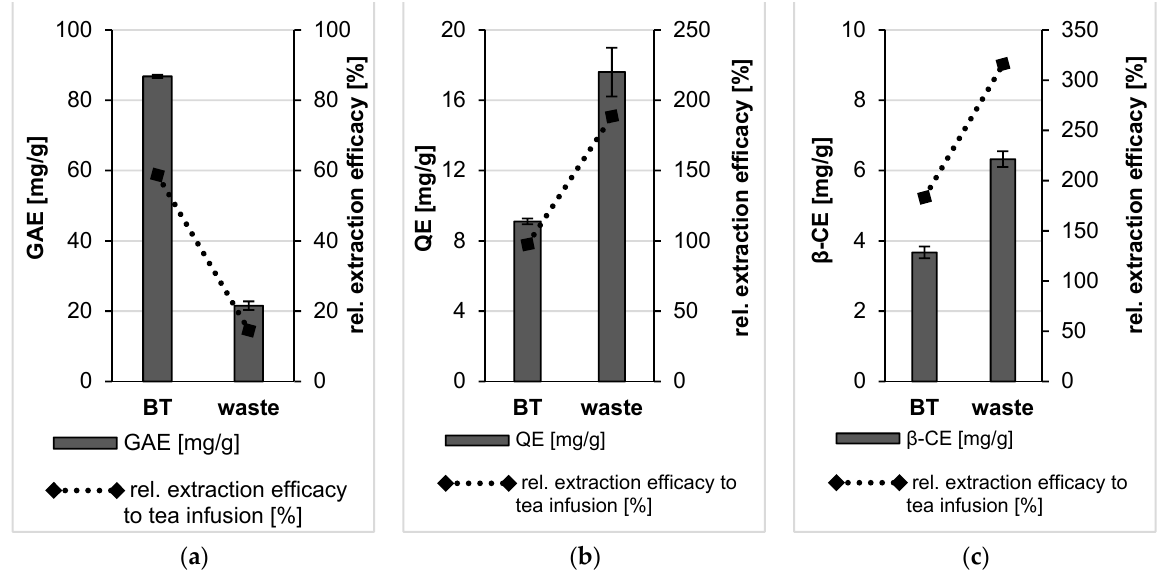
Figure 5. Determination of total polyphenol ( a ), flavonoid ( b ) and carotenoid contents ( c ) of the bulk suspensions from BT leaves and their waste. The polyphenol content is expressed in gallic acid equivalents (GAE), the flavonoid content is expressed in quercetin equivalents (QE) and the carotenoid content is expressed in β -carotene equivalents ( β -CE).